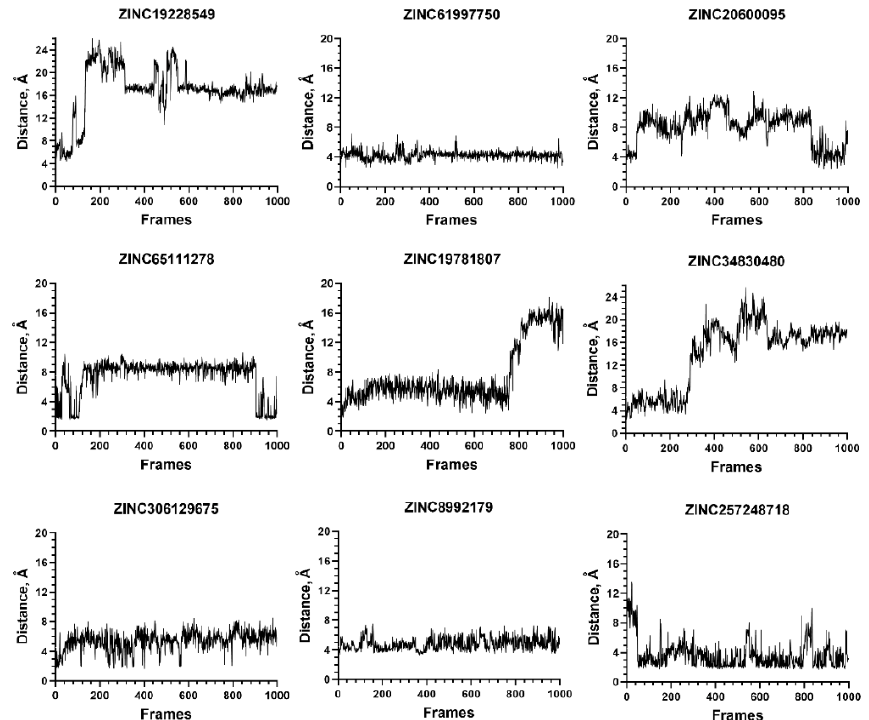
Figure 12. Stability of the ligand–protein complexes for compounds that do not interact with the C-terminus of NMT1. The values on the Y -axis show the distance between selected atoms during the MD simulation. For ZINC19228549, these were the atoms participating in a hydrogen bond with Gly284; for ZINC61997750, ZINC65111278, and ZINC257248718 — the atoms involved in a hydrogen bond with Tyr420; for ZINC20600095 — the atoms participating in a hydrogen bond between the ligand and coenzyme A; for ZINC19781807 — the distance between the ligand and Asn473; and for ZINC34830480 and ZINC306129675 — the distance to Gln496 (non-polar contact). Distance > 4 Å indicates instability.